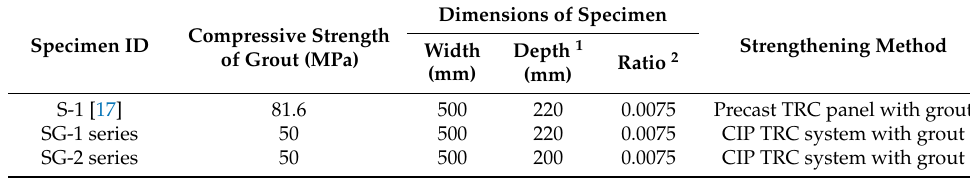
Figure 10. Crack pattern of specimens (bottom view). Table 6. Characteristics of RC slabs strengthened with TRC